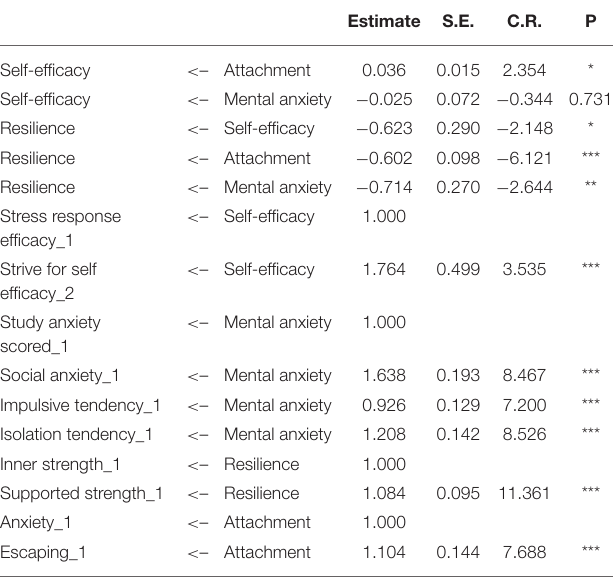
TABLE 8 | Hypothesis test